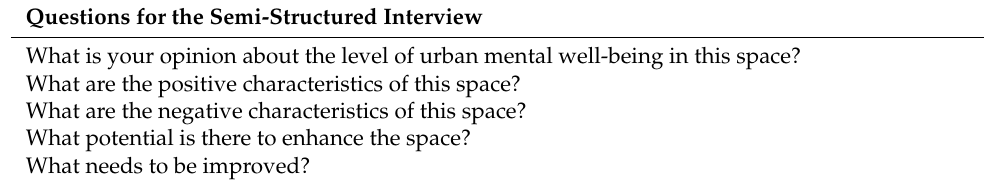
Table 2. The general questions of interviews. Questions for the Semi-Structured